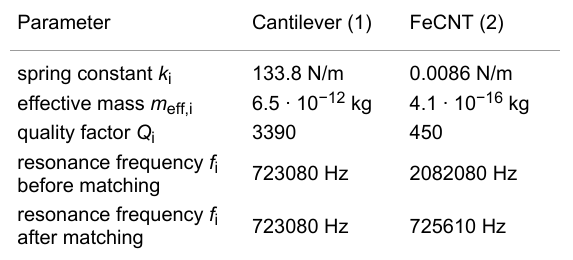
Table 1: Properties of cantilever and FeCNT constituting the coupled